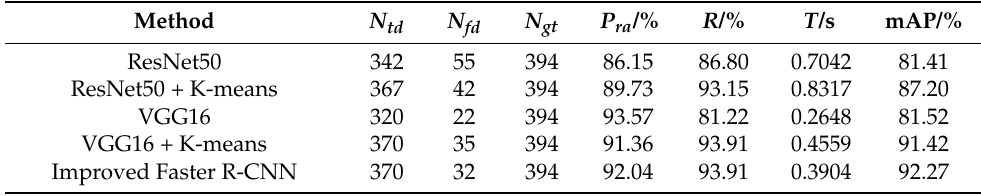
Table 4. Further experiments and